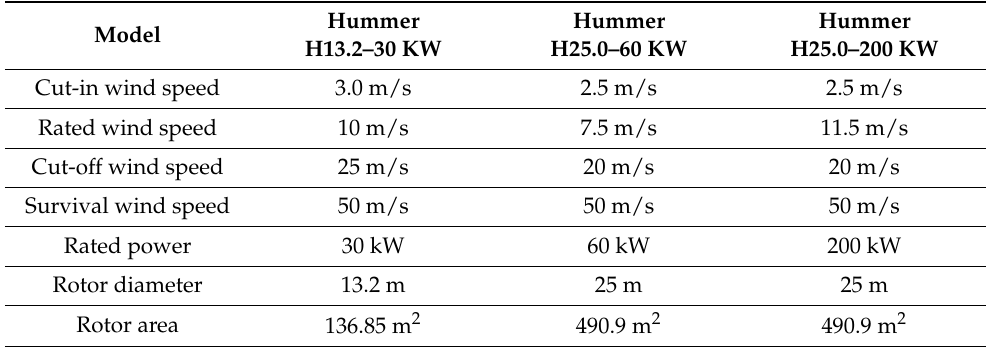
Table A2. Main data of selected wind turbine [57–59].